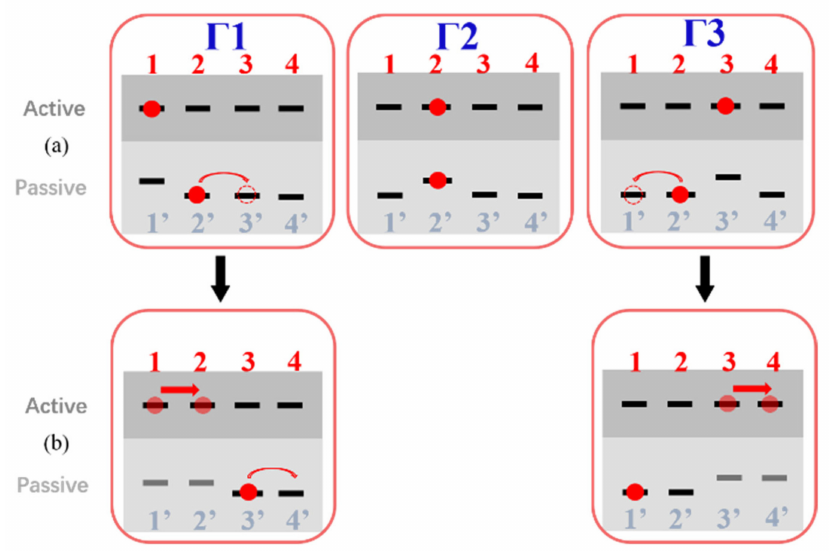
Figure 3. Mechanism for the positive hopping drag without lattice relaxation. ( a ) When the charge in the active line locates at site 1, a charge carrier at site 2 (cid:48) in the passive line has a larger probability of hopping forward. In contrast, this probability is offset when the charge in the active line moves to site 3 and no net current exists. ( b ) In a secondary order case, the forward hopping charge has some possibility of being driven forward by the same charge in the active line again, but the same charge would no longer drive the backward hopping